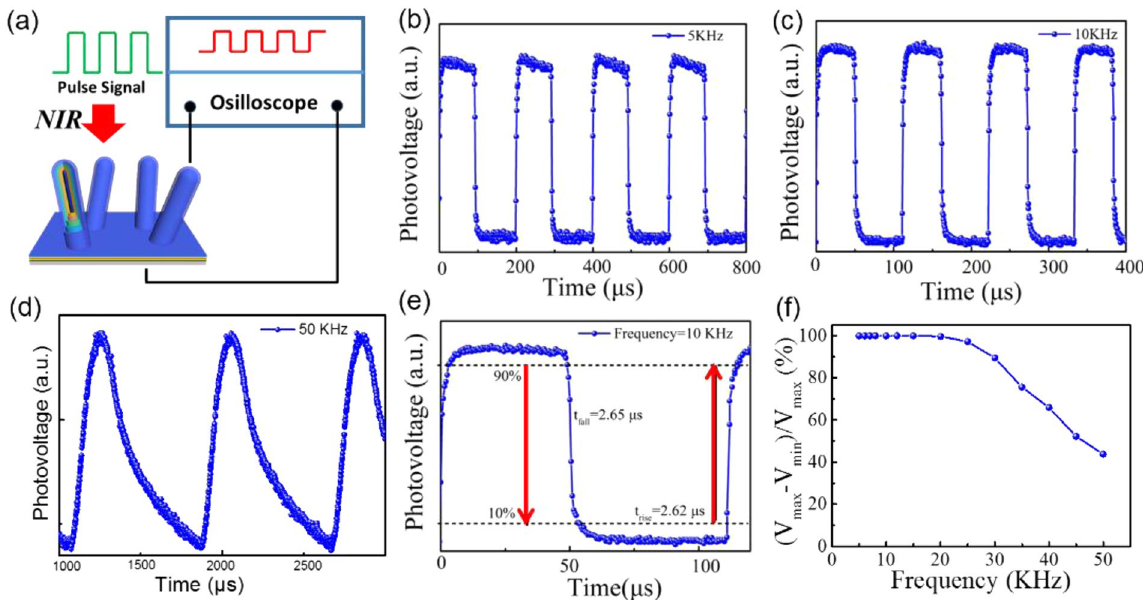
Figure 5. ( a ) Schematic illustration of RHJ PAL/a-Ge:H/a-Si:H PDs under pulsed NIR light irradiation (808 nm). Photoresponse of device under different frequencies: ( b ) 5 kHz, ( c ) 10 kHz, ( d ) 50 kHz. ( e ) The corresponding magnified plots of one response cycle @10 kHz at 808 nm wavelength. ( f ) Relative balance (Vmax-Vmin)/Vmax versus switching frequency from 5 kHz to 50